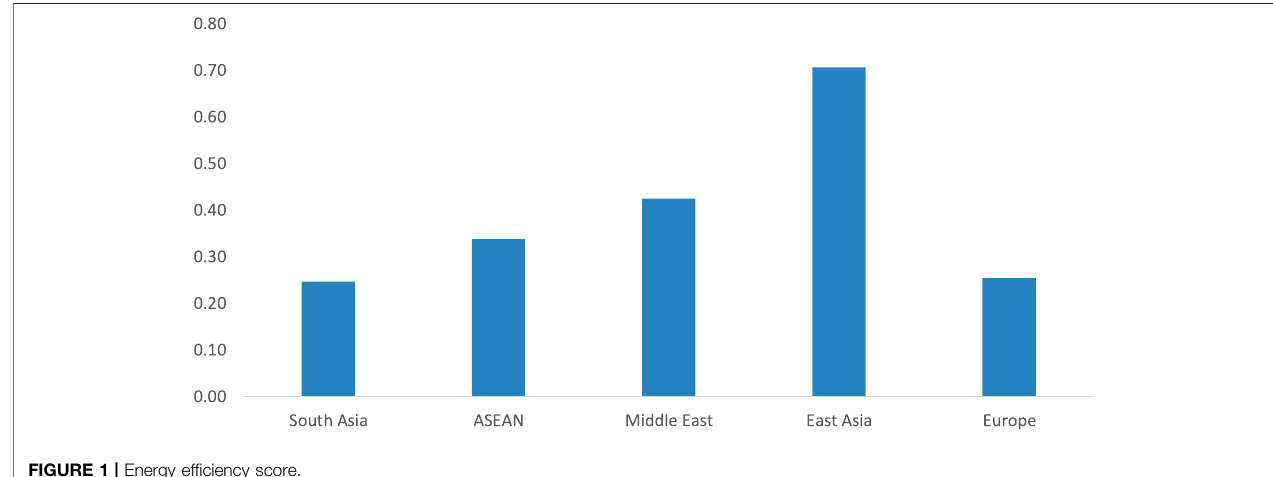
FIGURE 1 | Energy ef fi ciency score.